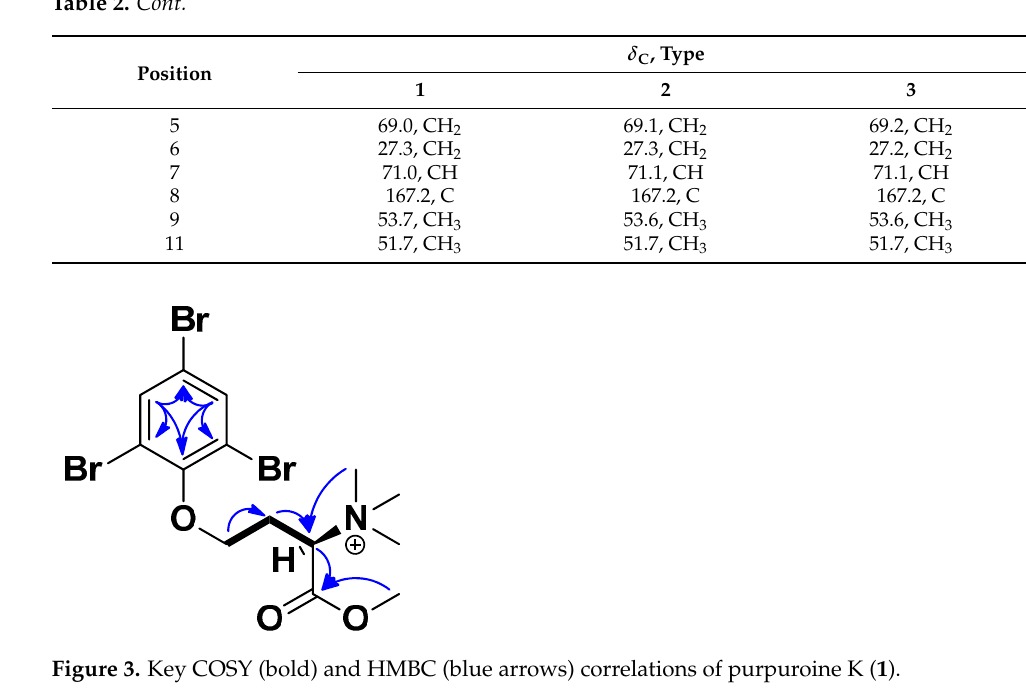
compound 1 (C-1: δ C = 117.9, C-3/C-3 (cid:48) : 118.6) and the brominated carbon atoms of